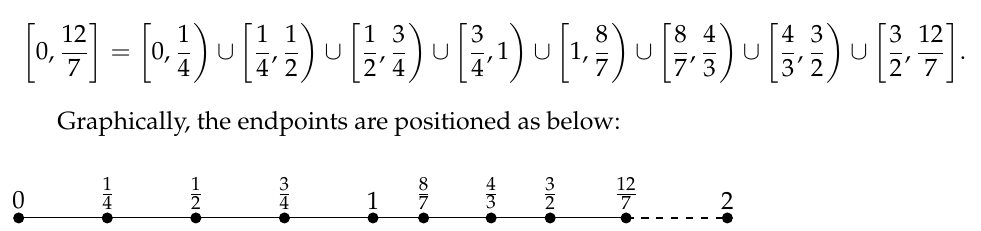
] into subintervals intersecting Z (cid:48) and with the length smaller than 0.285. Figure 2. Partition of [ 0, 12 7 The largest among the intervals of partition has length 1/4 (which is smaller than 2/7). Hence, we only need to prove that all endpoints belong to Z (cid:48) (since 0 ∈ Z (cid:48) ,